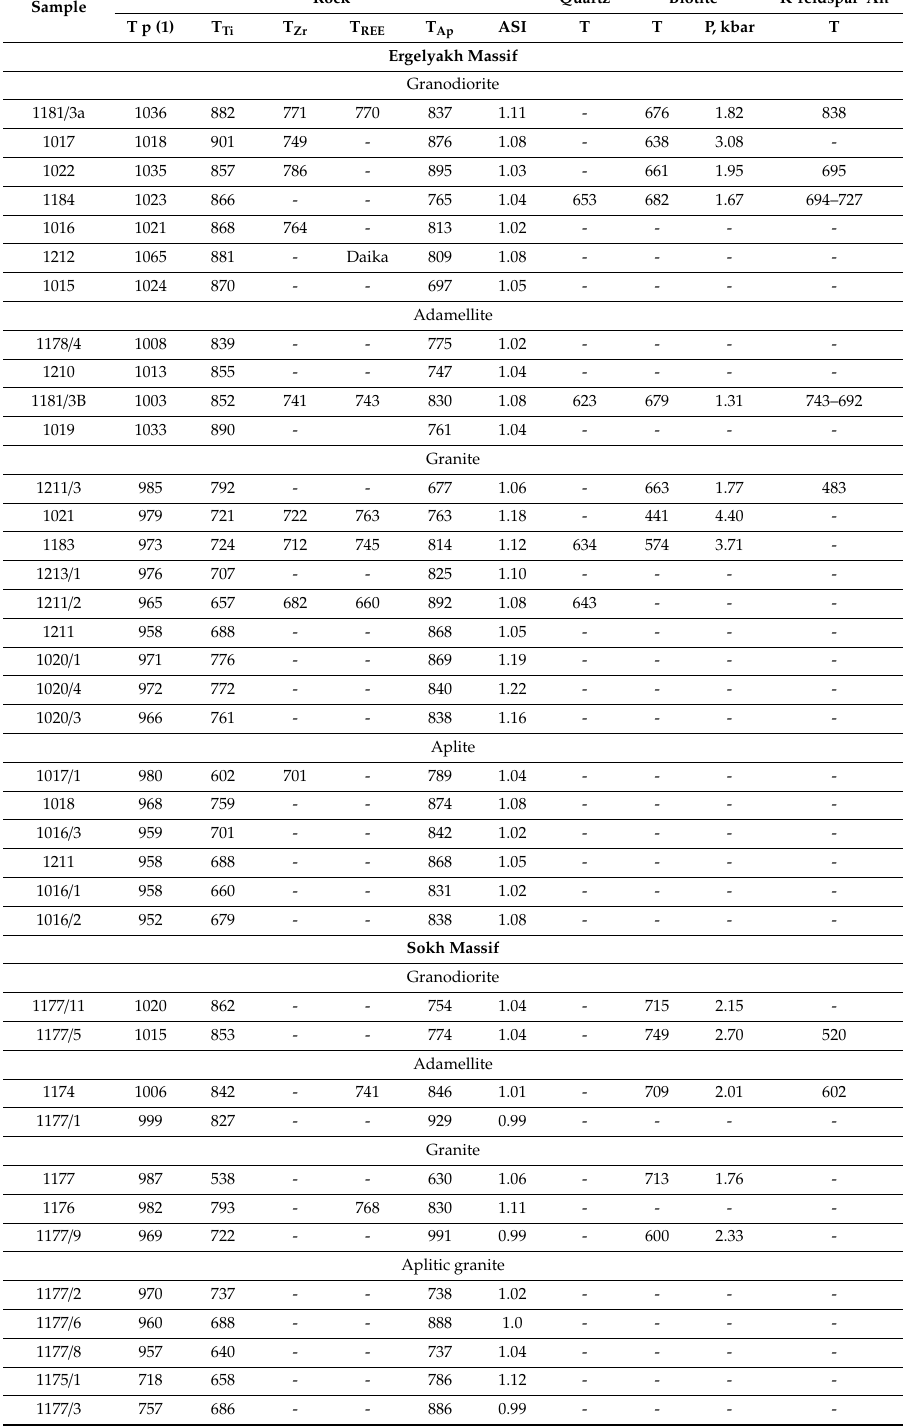
Table 9. Formation and crystallization temperatures of EIRGD